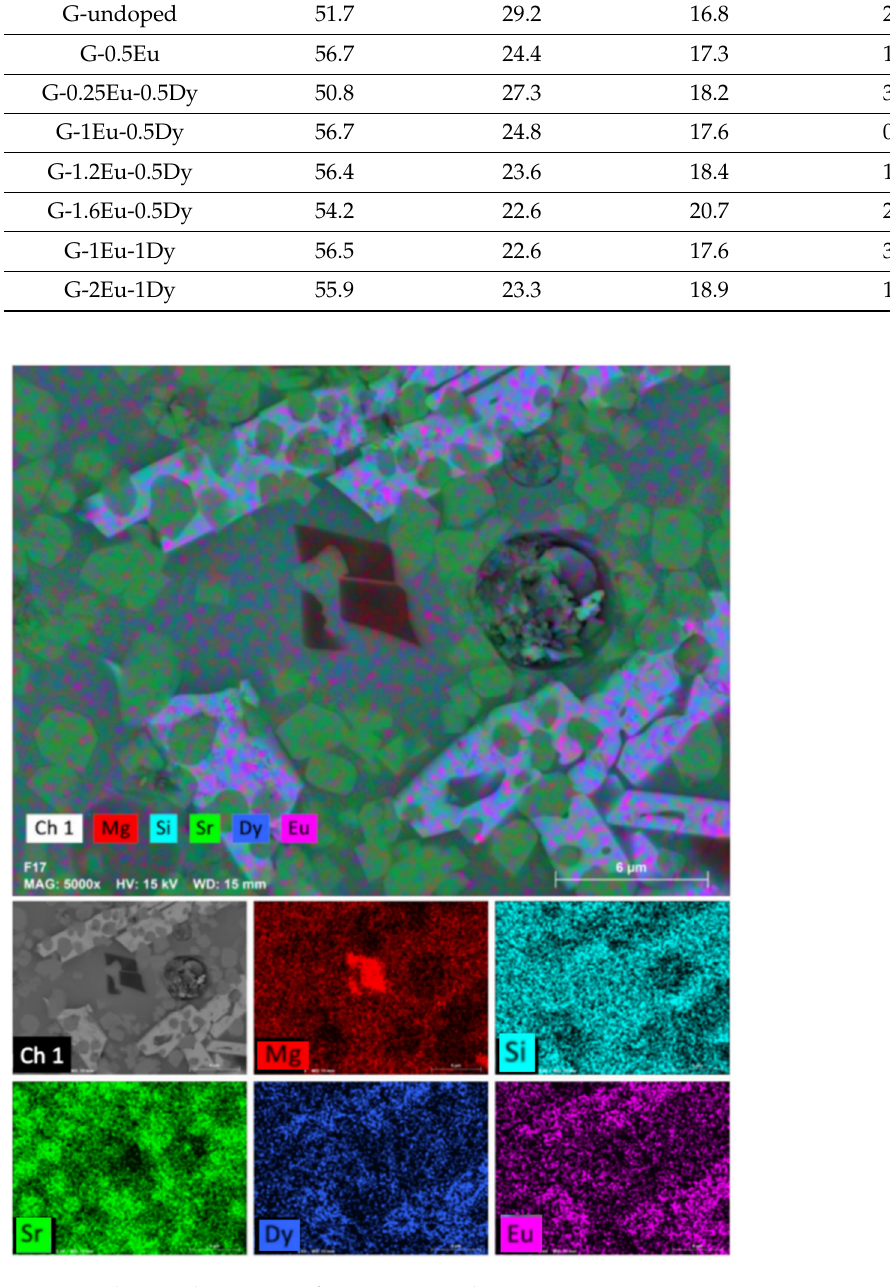
Figure 5. Elemental mapping of GC-1Eu-1Dy glass-ceramic. The glass-ceramic microstructure and the crystals responsible for the emission can be observed by means of the panchromatic CL images in Figure 6. The images correspond to the surface of a polished pellet sample of GC-1Eu-1Dy, with the microscope focused on the central part of the pellet. In the images presented below, SEM (black and white) and panchromatic (green) images corresponding to the same area of the pellet are compared. The green emission originated from all grey microcrystals, while the residual glassy phase remained